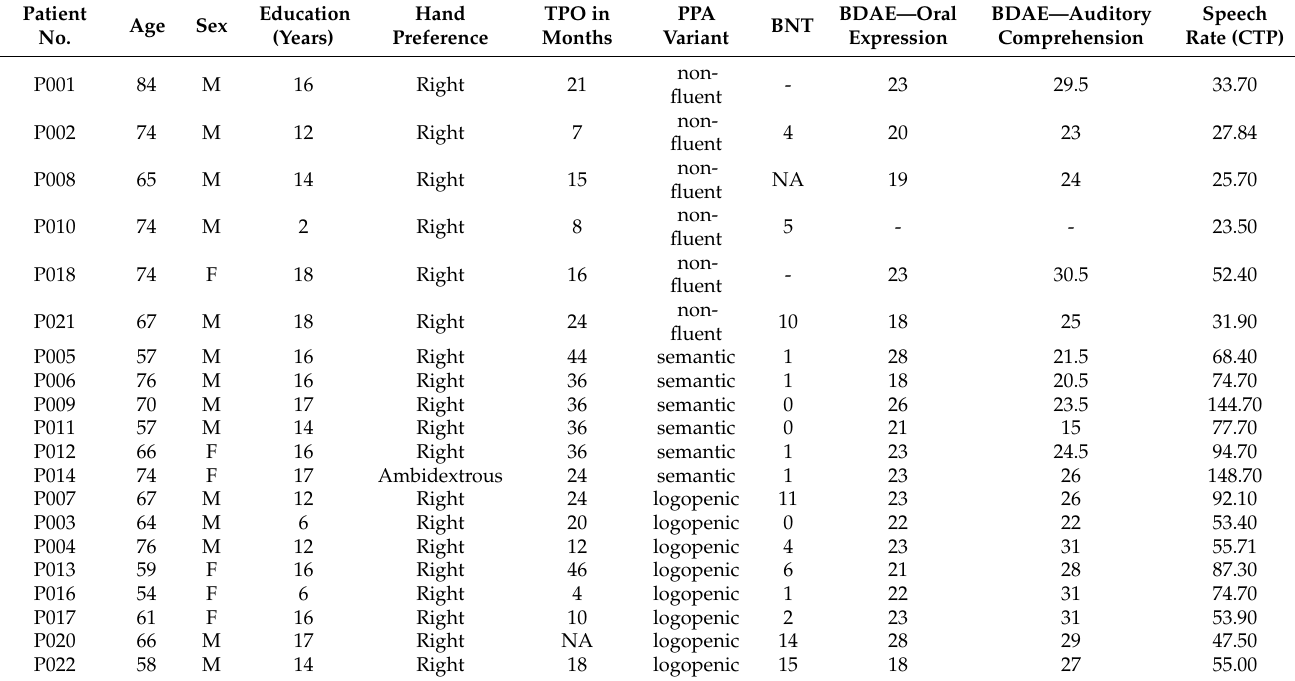
Table 2. Demographic and clinical characteristics of the PPA